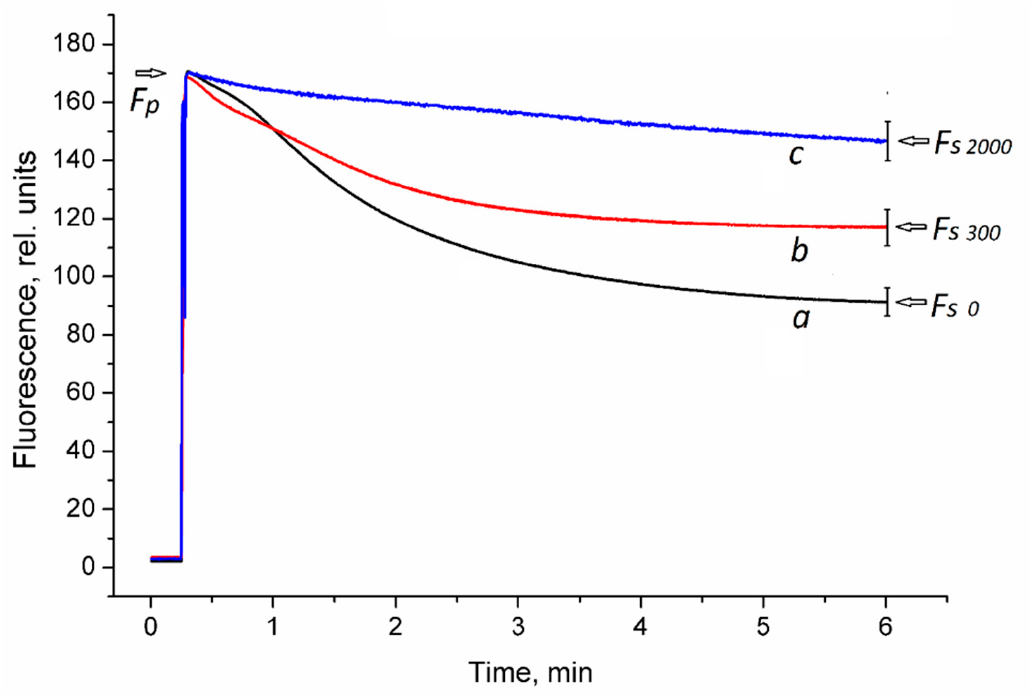
Figure 5. Chlorophyll fluorescence kinetics in H. sativum leaves from plants germinated in the presence of different